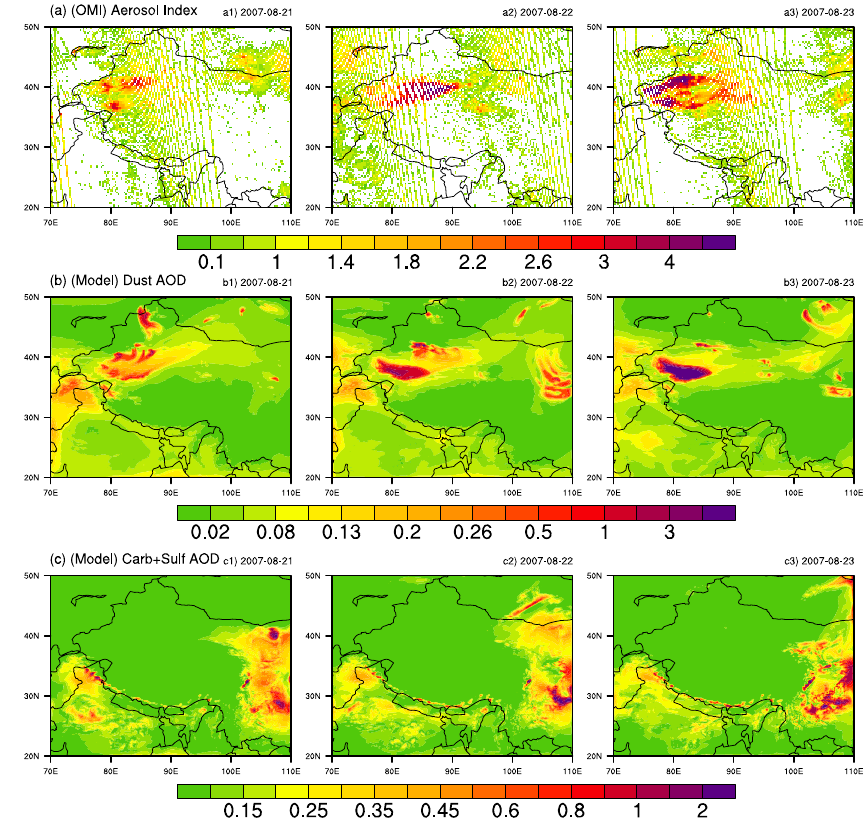
Figure 3. Daily mean distribution of the (a) AI retrieved from the OMI satellite data and simulated optical depth of (b) dust aerosols and (c) carbonaceous and sulfate aerosols from 21 to 23 August